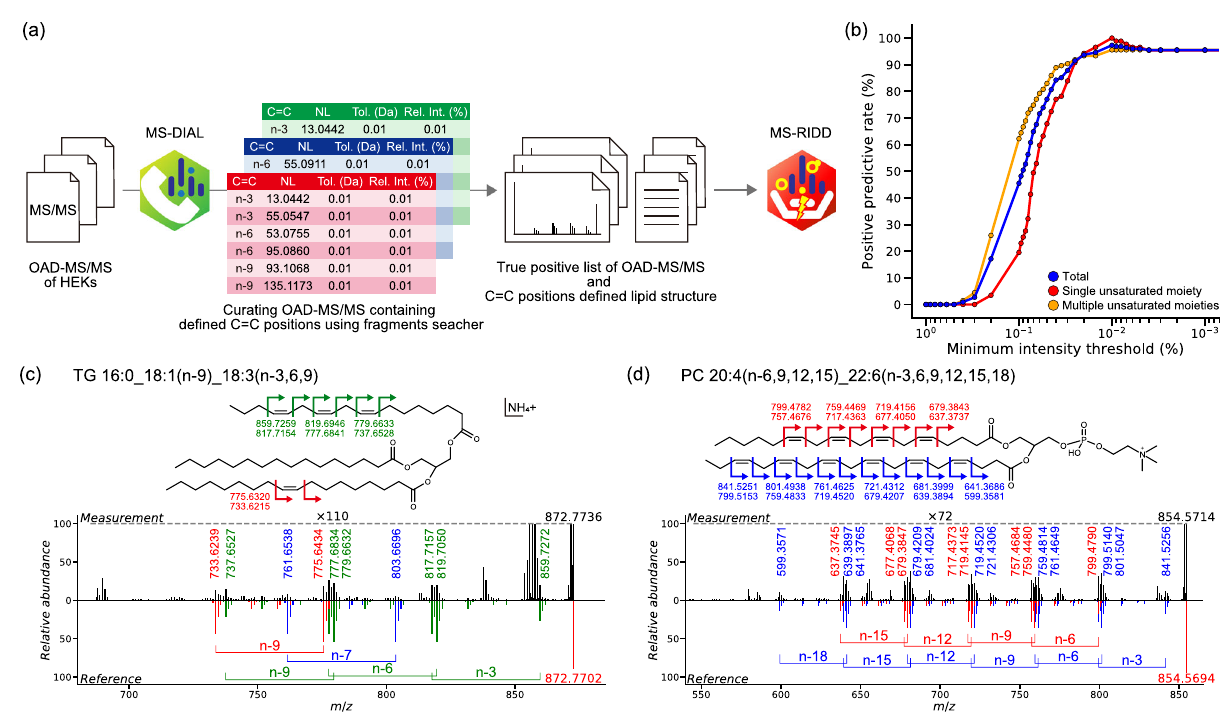
Fig. 4 Summary of the construction process of true positive spectral records and the validation of mass spectrometry radical-induced dissociation decipherer (MS-RIDD) program. a The essential neutral losses for α -LA, γ -LA, ETA, ARA, EPA, DPA, OsA, and DHA were manually con fi rmed with the fragment searcher function of MS-DIAL 4. b Positive predictive value (%) of the MS-RIDD annotation algorithm in each minimum intensity threshold, where the results are displayed by three conditions: total, single unsaturated moiety and multiple unsaturated moieties. Representative annotation result of two or three unsaturated moieties ( c ) TG 16:0_18:1(n-9)_18:3(n-3,6,9) and ( d ) PC 20:4(n-6,9,12,15)_22:6(n-3,6,9,12,15,18). The theoretical m/z values of product ions are described along with the chemical structures while the experimental m/z values are shown in the line chart of MS/MS spectrum. In the reversible spectral charts, the top- and bottom panels show the experimental and reference MS/MS spectrum,